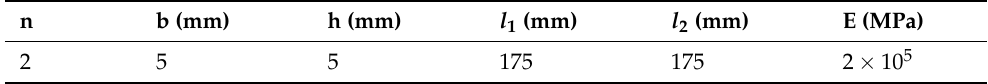
Table 1. Structure parameters of the FFN plate model.